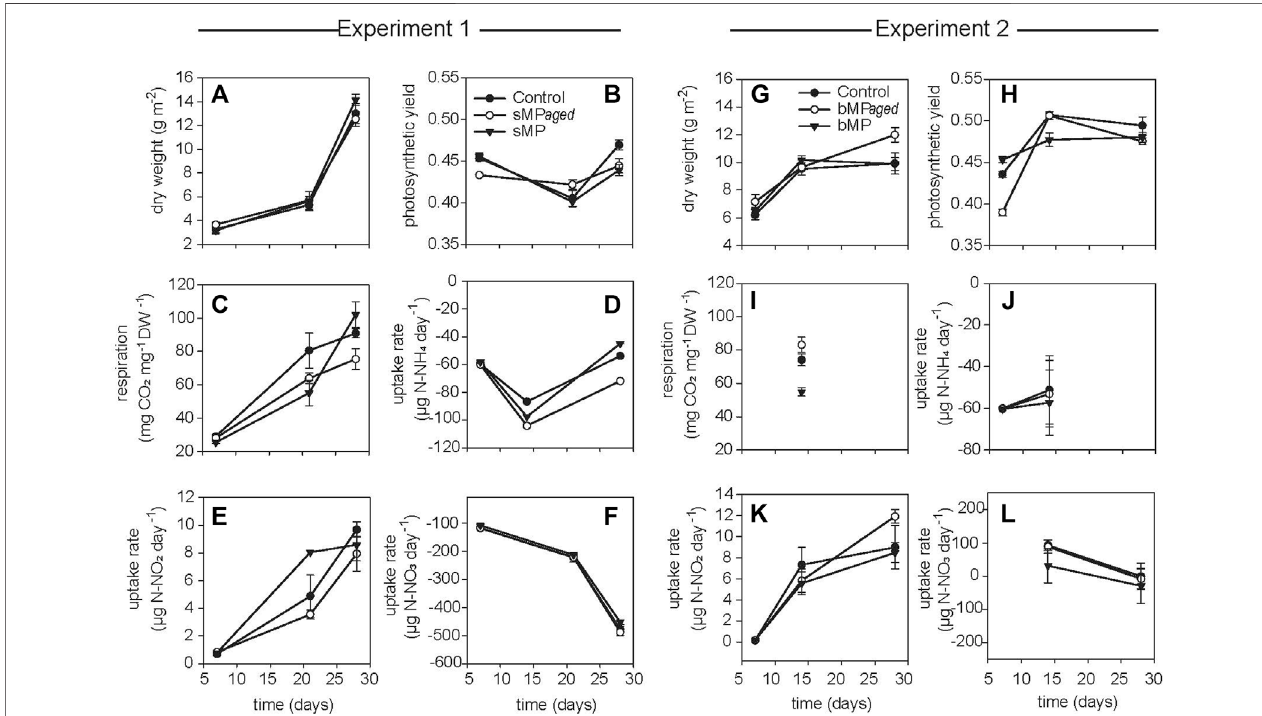
FIGURE2| Periphytondescriptorsresultingfromexperiment1(leftpanels,sMP/sMP aged )and2(rightpanels,bMP/bMPaged).Representedaredryweight (A,G) , photosynthetic yield (B,H) , respiration (C,I) , and N-NH 4+ (D,J) , N-NO 2- (E,K) and N-NO 3- (F,L) uptake rates. The treatments are represented as black dots for control, white dots for UV-treated MP and black triangle for MP with native surface. Shown are the mean of fi ve biological replicates; whiskers indicate the standard error of the mean.